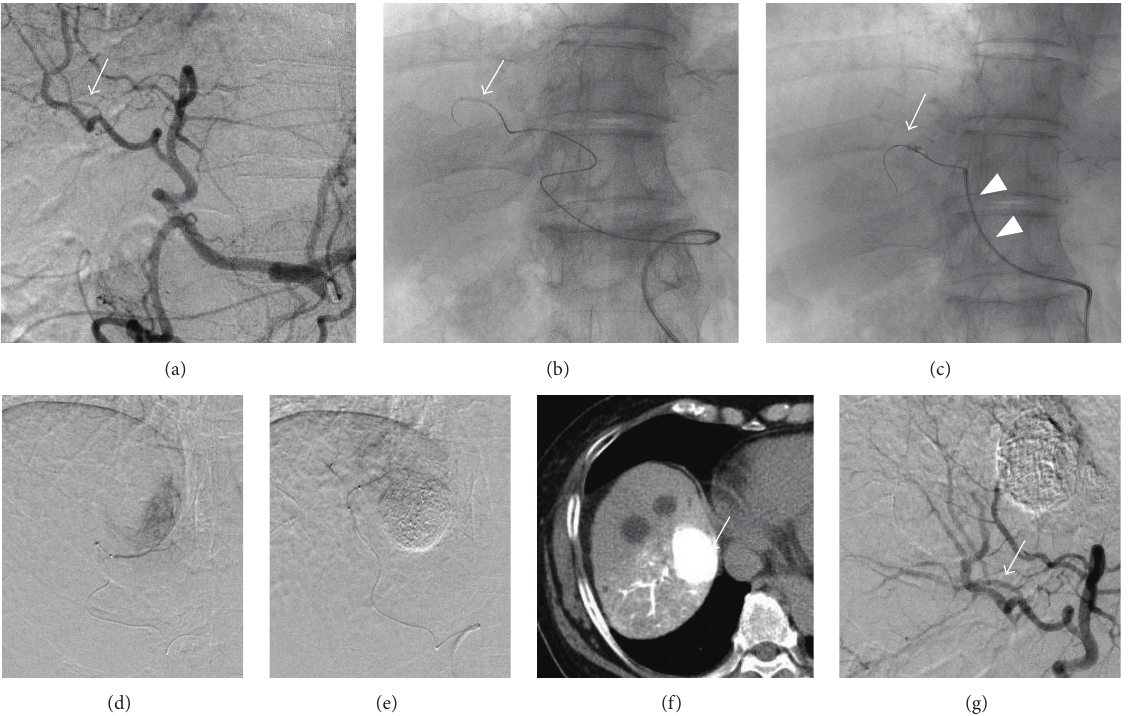
Figure 2: ((a) and (b)) A 1.8Fr tip coaxial microballoon catheter was inserted into a branch in segment five (arrow) that was unrelated to the feeding arteries of the tumor in segment eight. (c) The microballoon was inflated in the vessel (arrow) and the parent catheter was advanced into the right hepatic artery (arrowheads). ((d), (e), and (f)) Selective transarterial chemoembolization using miriplatin was performed and dense lipiodol deposition in the tumor was visible in the postprocedure computed tomography images. (g) Including the vessel in which the microballoon was inflated (arrow), no vascular complications were confirmed in the postprocedure